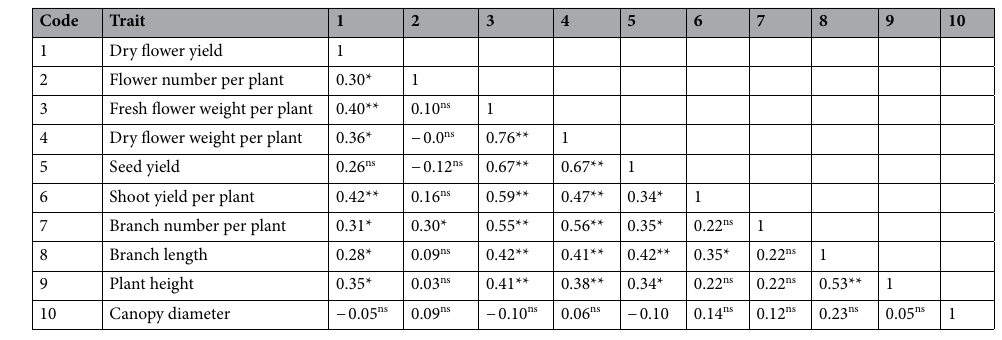
Table 5. Coefficients of correlation between growth characteristics and yield of Echium amoenum affected by different types of fertilizers and plant densities. **, * and ns are significant at the 0.01 and 0.05 of probability level and non-significant,